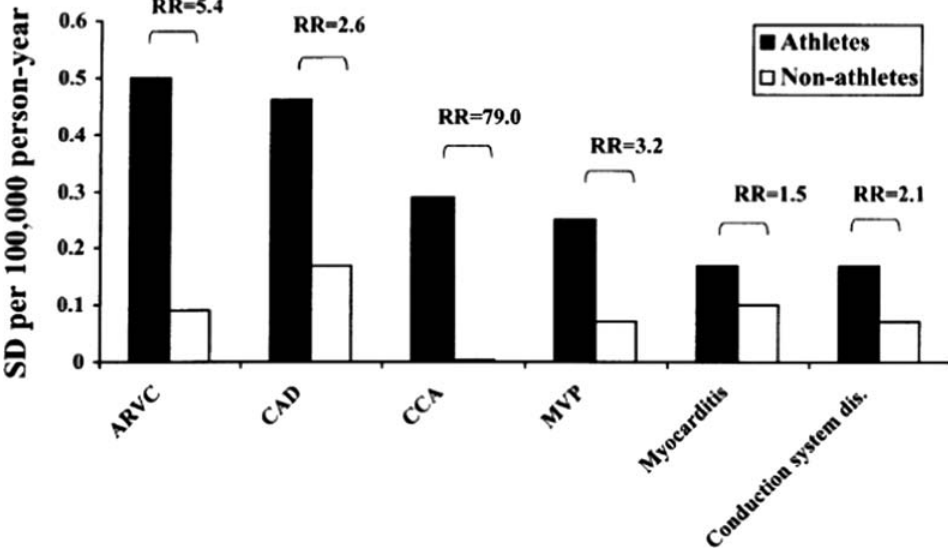
Figure 11. Incidence and relative risk (RR) of sudden death (SD) for specific cardiovascular causes among athletes and non-athletes. ARVC: arrhythmogenic right ventricular cardiomyopathy; CAD: coronary artery disease; CCA: congenital coronary artery anomaly; MVP: mitral valve prolapse. Adapted from Corrado, D., Basso, C., Rizzoli, G., Schiavon, M. & Thiene, G. Does sports activity enhance the risk of sudden death in adolescents and young adults? J Am Coll Cardiol. 42, 1959-63